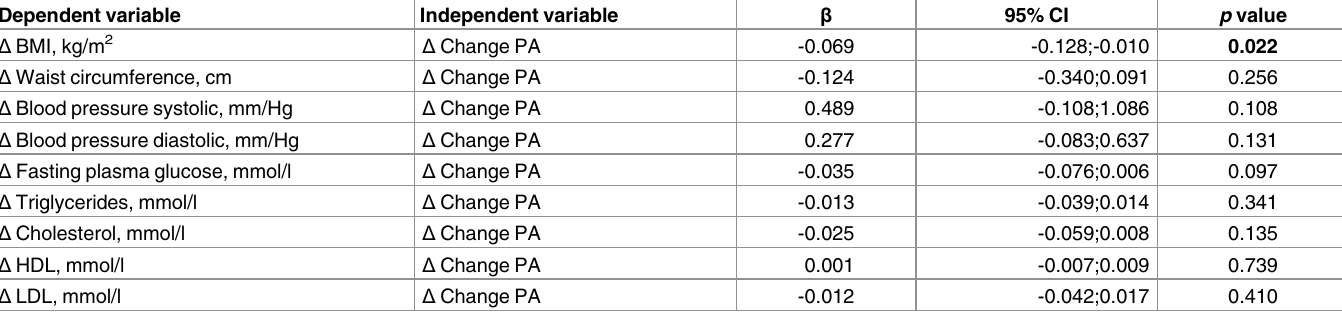
Table 6. Results for univariate linear regression analysis investigating the association between change in PA and metabolic risk factors at 6-month follow-up a .